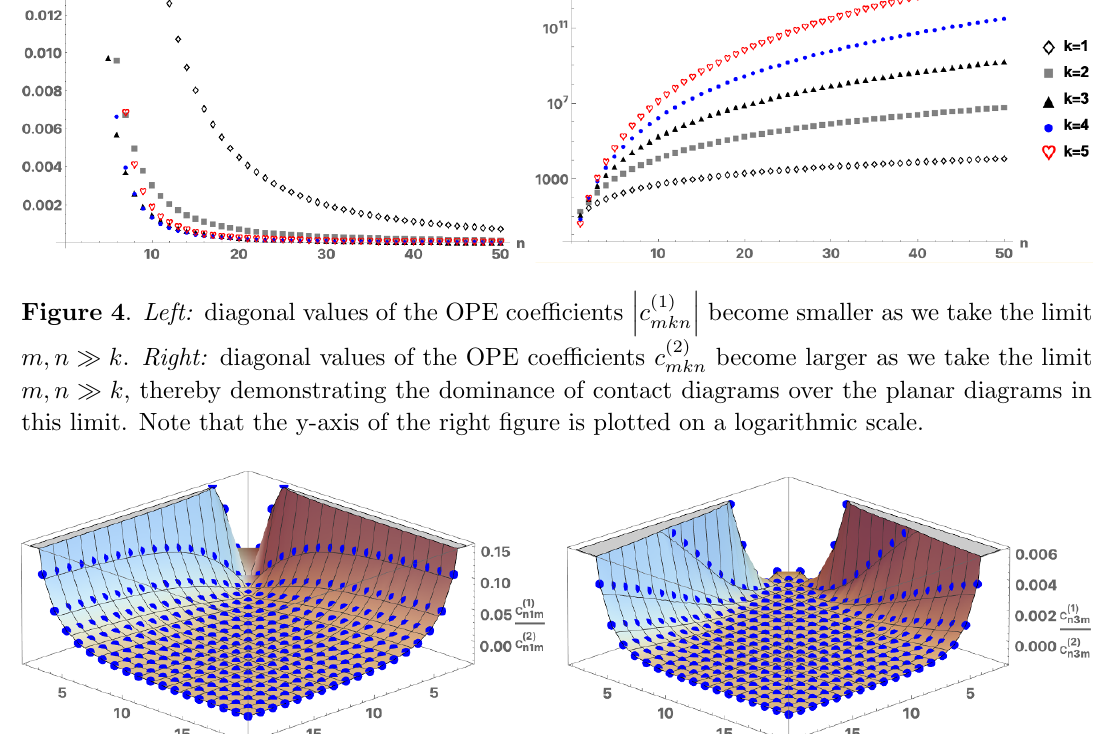
(cid:12) (cid:12) (1) (2) (cid:12) (cid:12) is largely suppressed even for k = 1 as m or n are increased. (cid:12) c (cid:12) =c m 1 n m 1 n